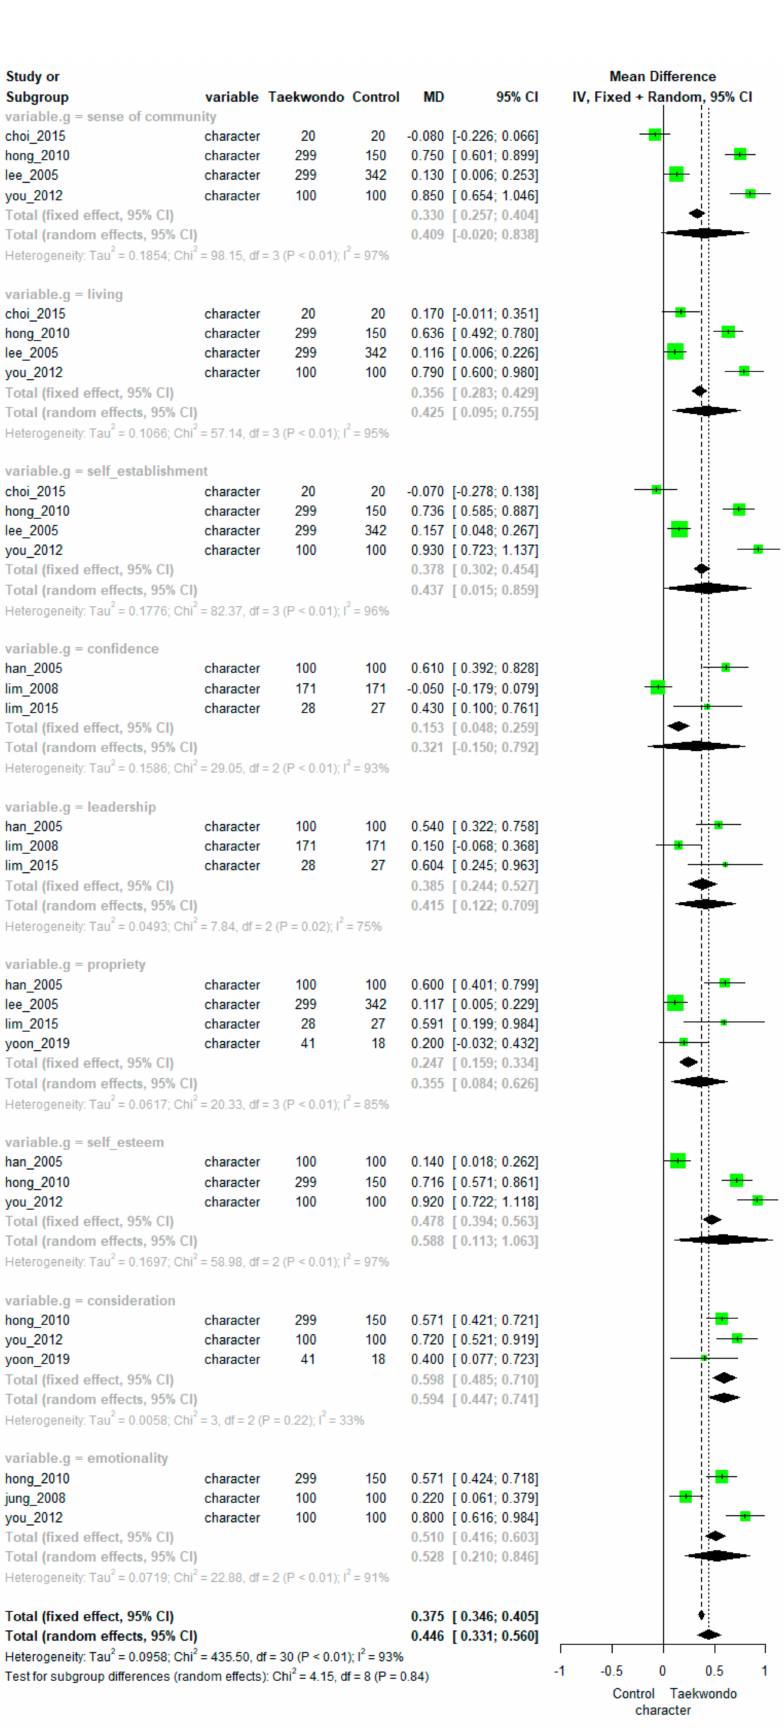
Figure 3. Forest plot of Taekwondo effects on